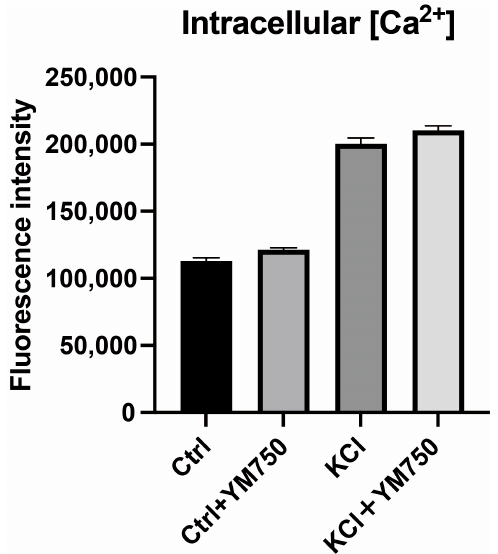
Figure 4. Effect of YM750 (10 mM) on intracellular calcium concentration by KCl (20 mM) stimulation. n =